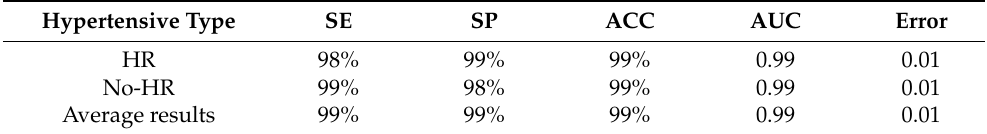
Table 4. Performance metrics of the